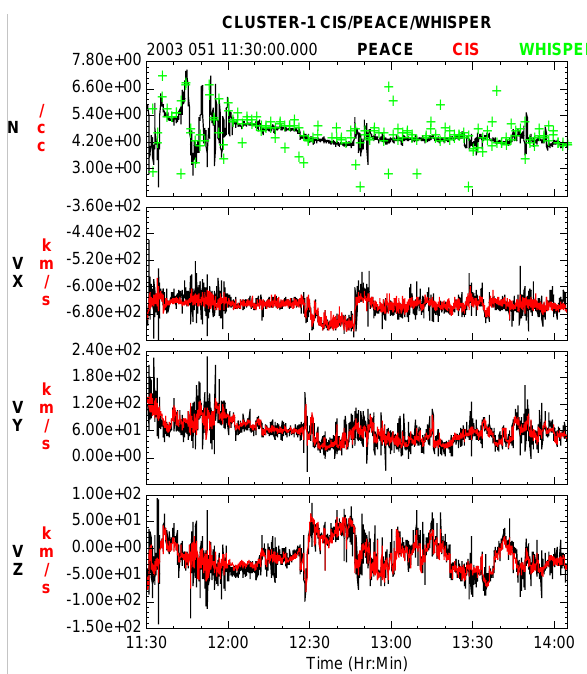
Fig. 1. Comparison of PEACE (black), CIS (red) and WHISPER (green) derived plasma moments in the solar wind from 20 February 2003 from 11:30:00 to 14:05:00UT. Data was obtained from the C1